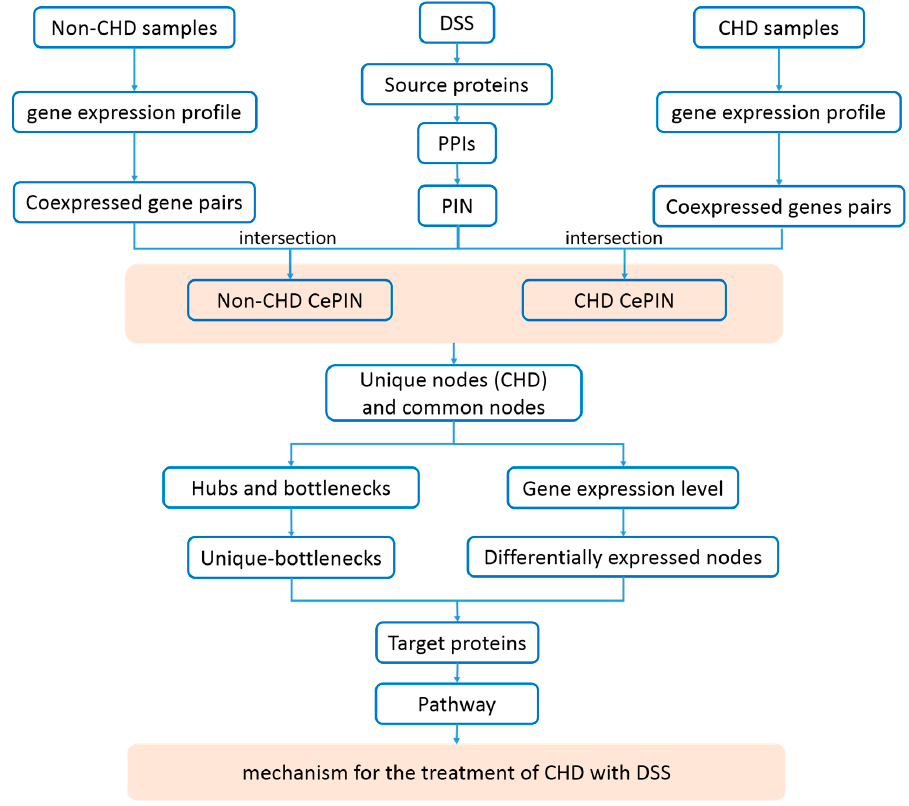
Figure 1. The whole framework of this study is based on a coexpression protein interaction network (CePIN) for the identification of mechanisms for the treatment of coronary heart disease (CHD) with Danshensu (DSS).